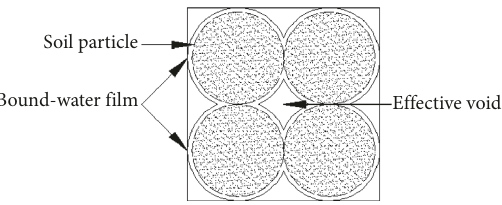
Figure 4: Bound-water film and effective void for